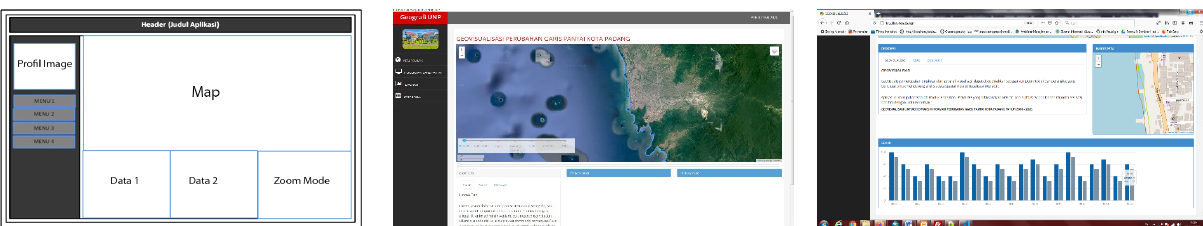
Figure 7. Geovisualization application design